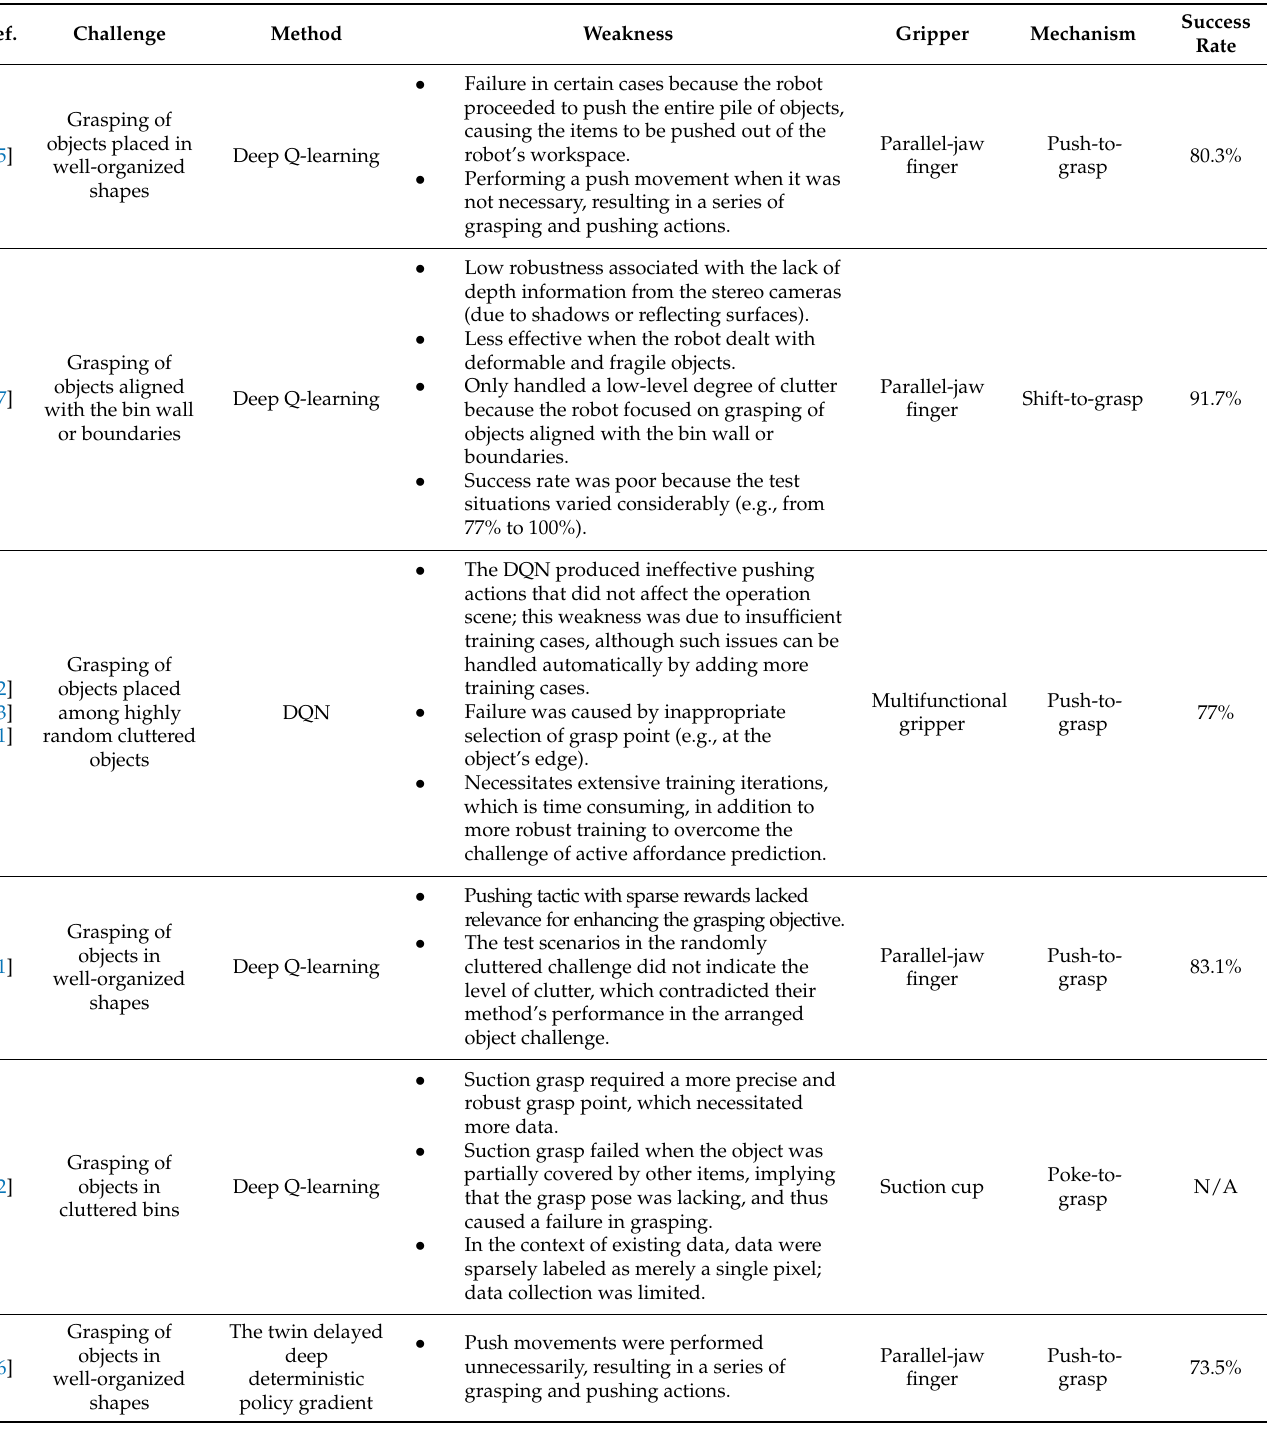
Table 3. Important related studies involving the synergy of two actions based on object manipulation in cluttered